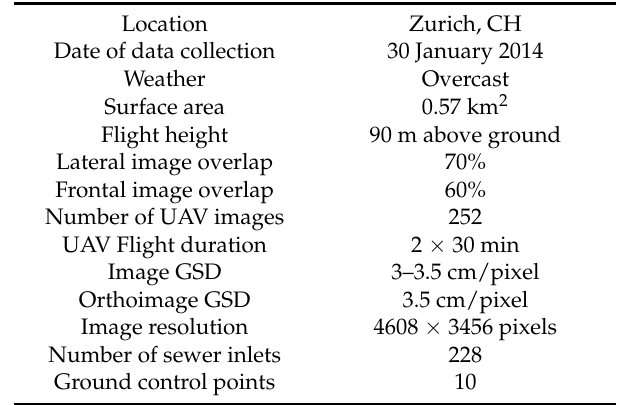
Table 2. Characteristics of the study area, UAV flight, and